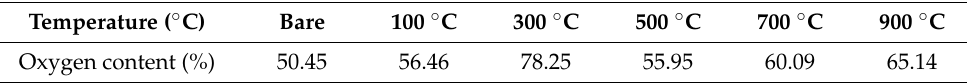
Figure 1. XPS scans of (I) bare Ti6Al4V, and (II-VI) heat-treated Ti6Al4V (II: 100 °C, III: 300 °C, IV: 500 °C, V: 700 °C, and VI: 900 °C). Table 1. Relative content of O on Ti6Al4V surface at different temperatures.